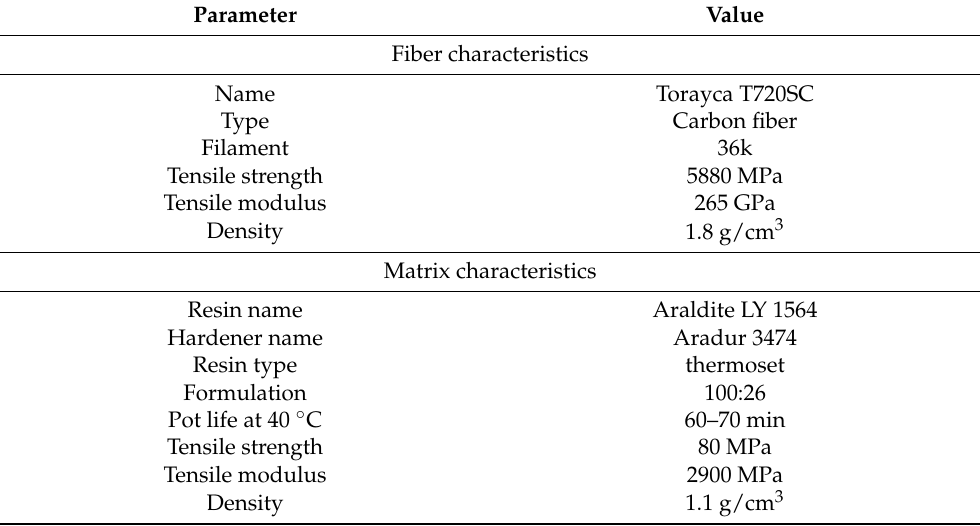
Table 1. Fiber and matrix